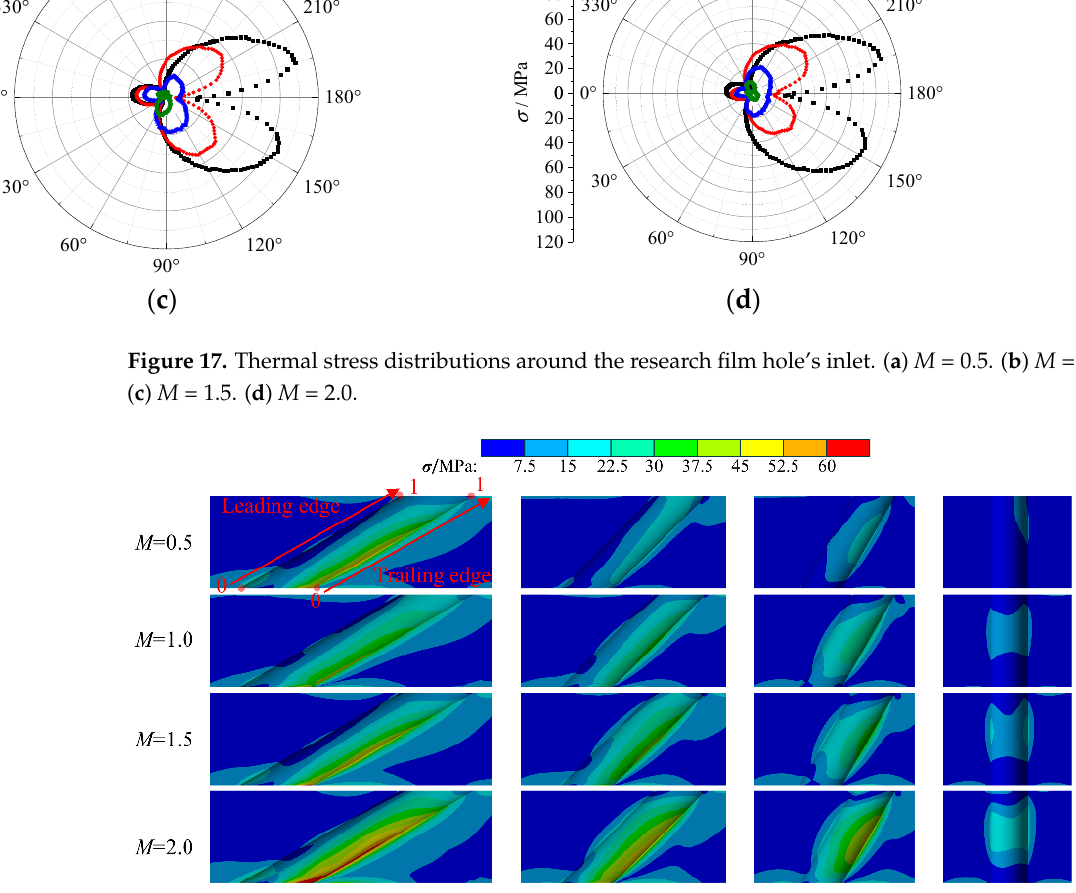
1.0. ( c ) M = 1.5. ( d ) M = 2.0.